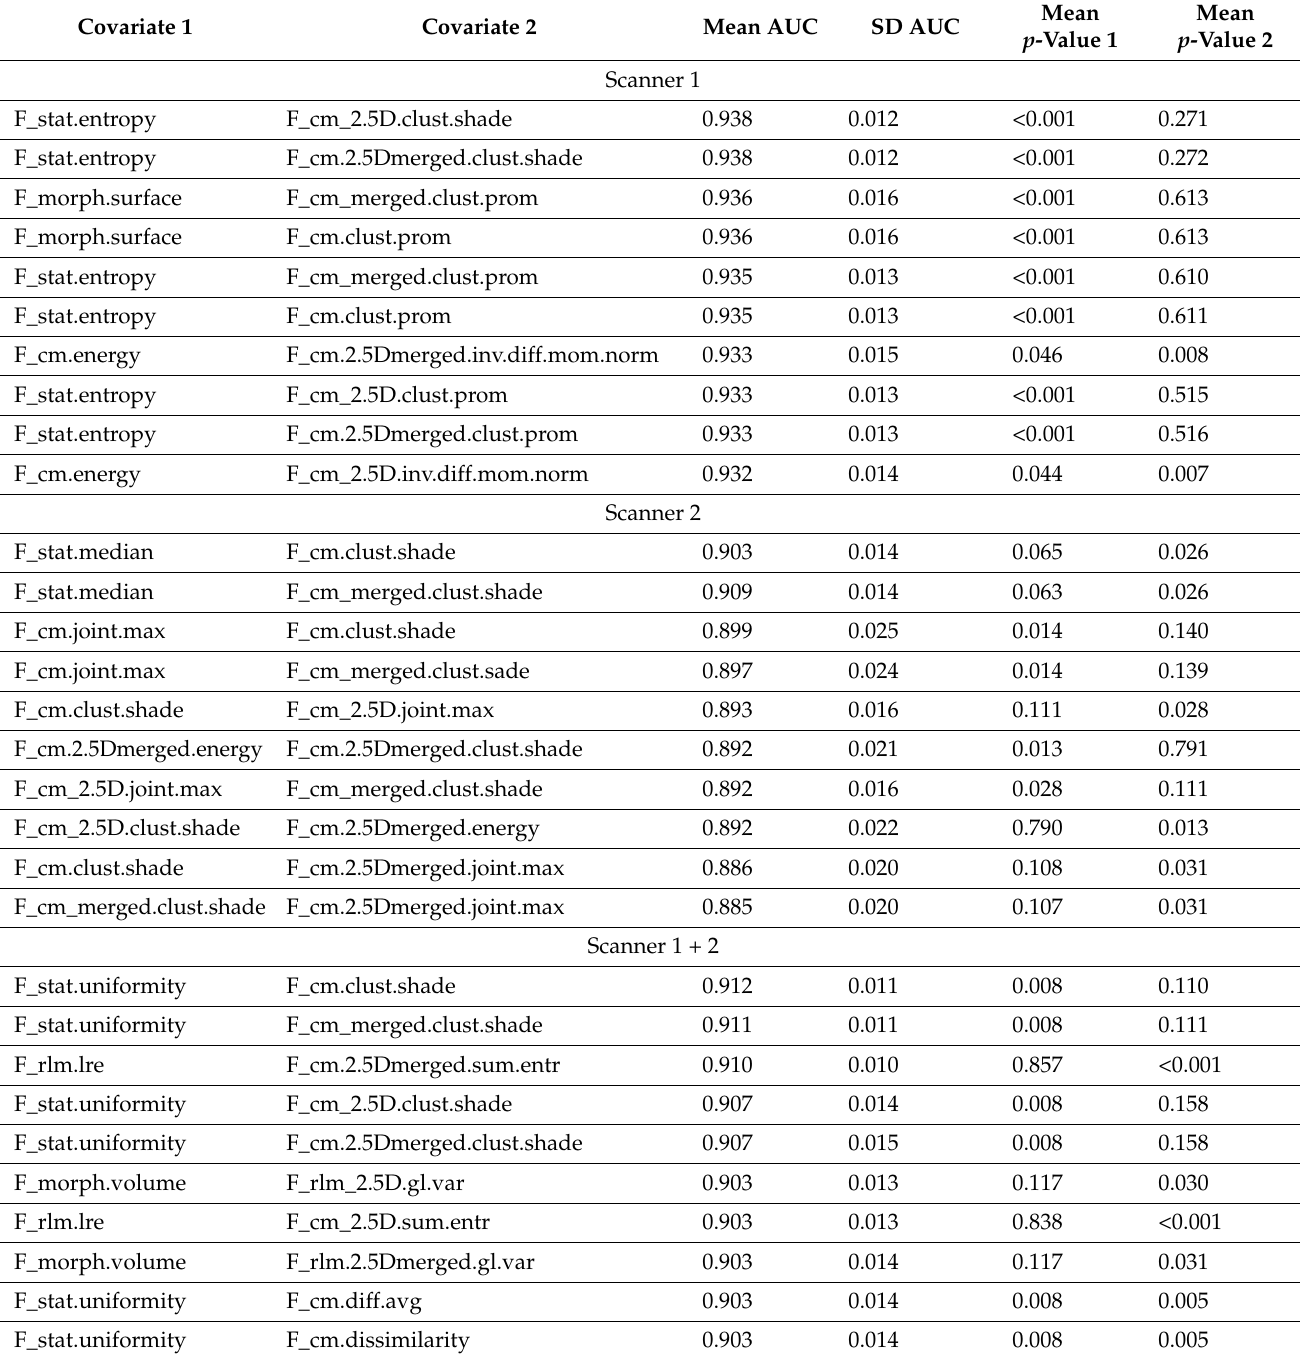
Table 3. Couples of RaF with best performances at k-nearest neighbors analysis for scanner 1, scanner 2 and both scanners